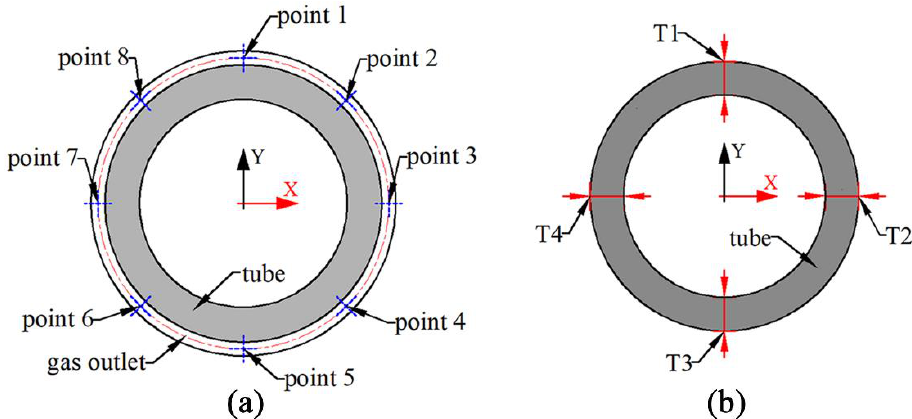
Figure 4. Schematic diagram of the calibration point at the gas outlet boundary. ( a ) Location plot of the calibration points at the gas outlet boundary; ( b ) Location plot of the micro-tube thickness measurement. Table 1. X-Y coordinate values for each calibration point.